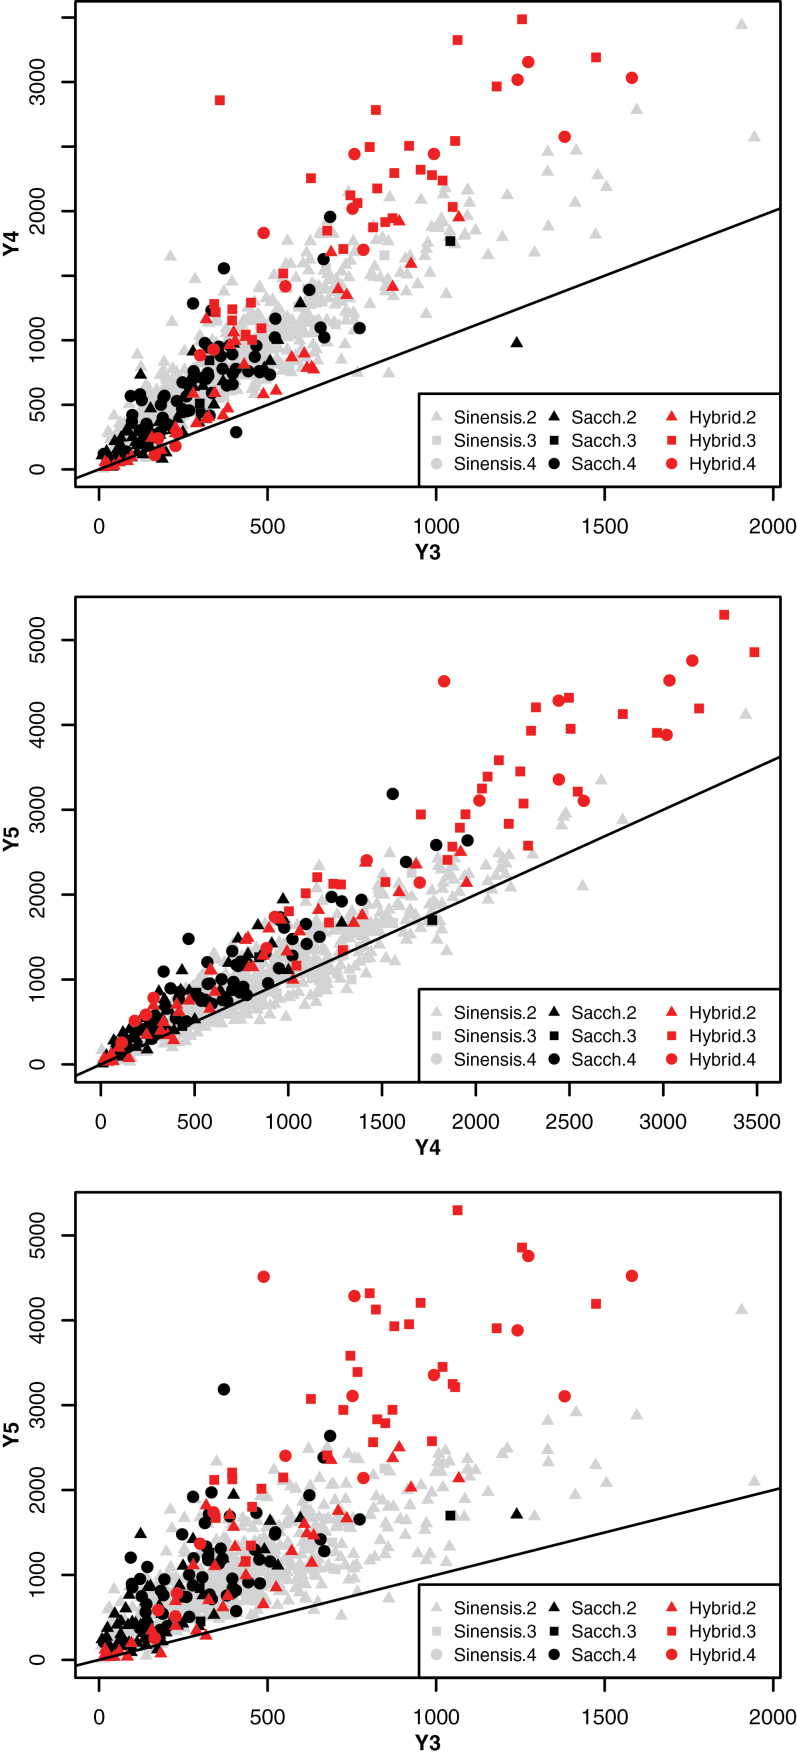
Year-on-year trends for DMY for all plants by species: M. sinensis (grey), M. sacchariflorus (black), and hybrid (blue); and by ploidy: diploid (triangle), triploid (square), and tetraploid (circle). The line of equality, x=y, is represented by a black line.